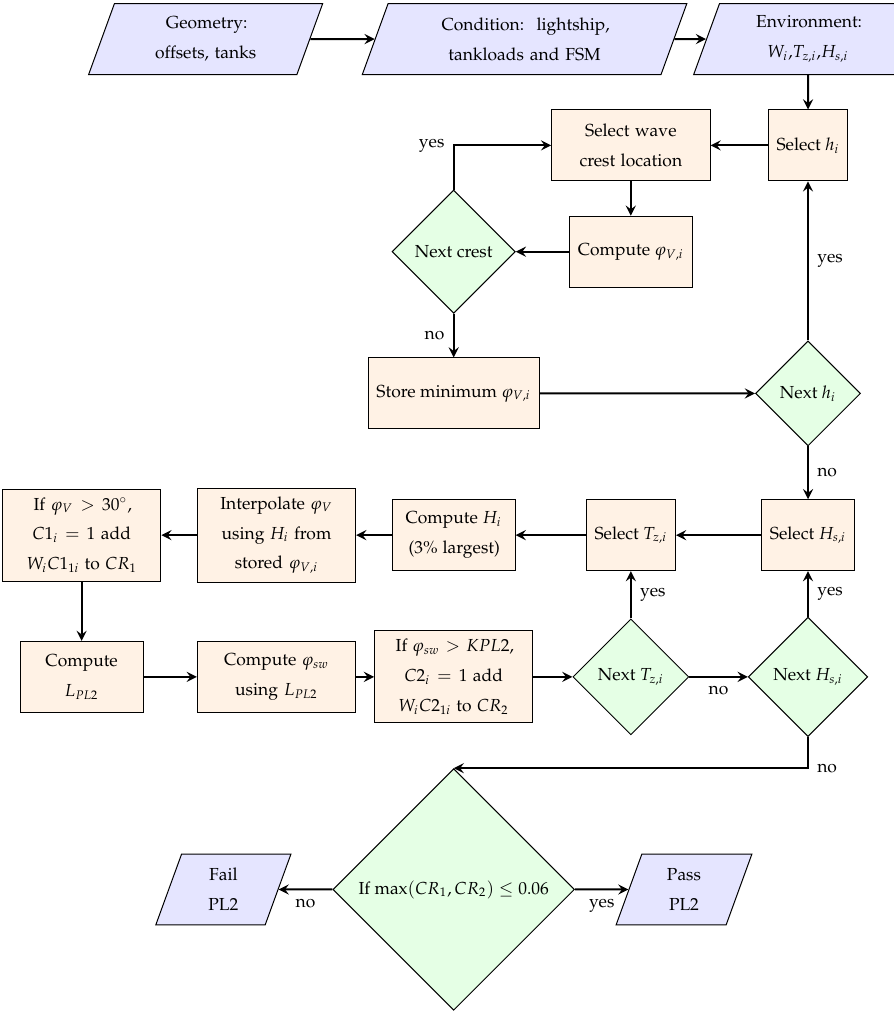
Figure 11. Pure loss level 2 algorithm process diagram.